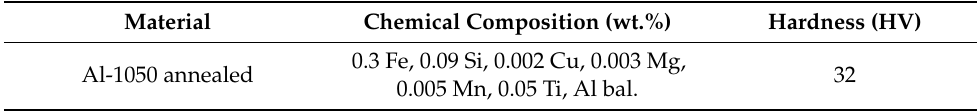
Table 1. Chemical composition and hardness of the Al-1050 sheet.